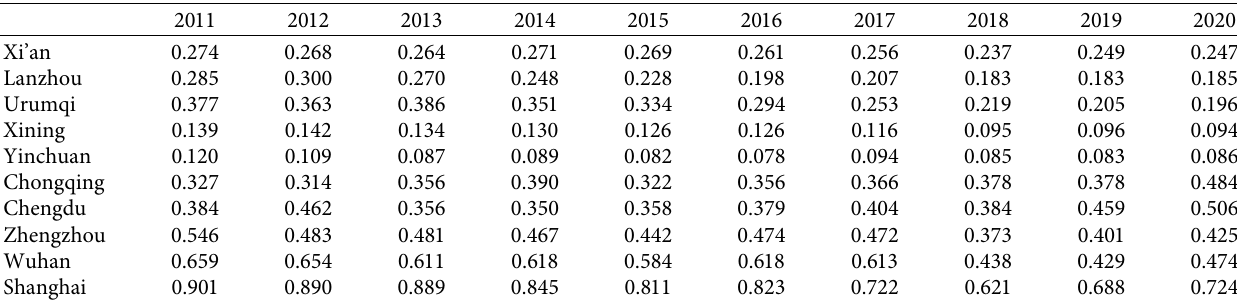
Table 2: Environmental efficiencies of some node cities in Chinese section of the SREZ in 2011–2020.